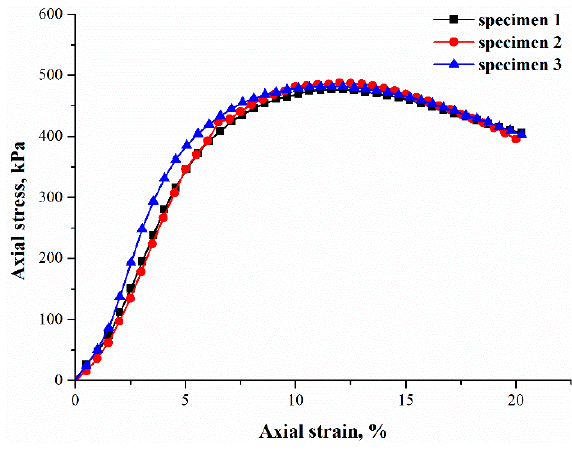
Figure 2. Stress–strain curves of three parallel specimens: ( = 0.2%, = 3%, and = 1.5 g/cm 3 ).